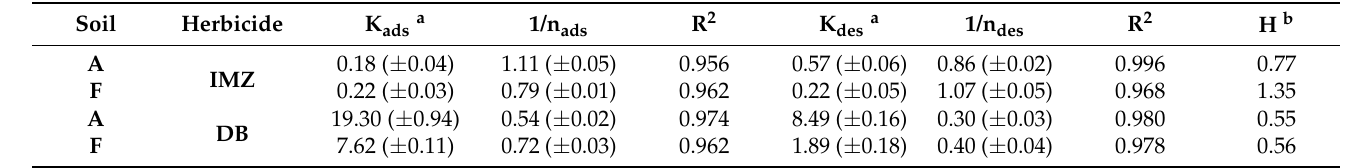
Table 3. Freundlich parameters (mean values ± SE) for imazamox (IMZ) and 2,4-DB (DB) sorption– desorption in A and F